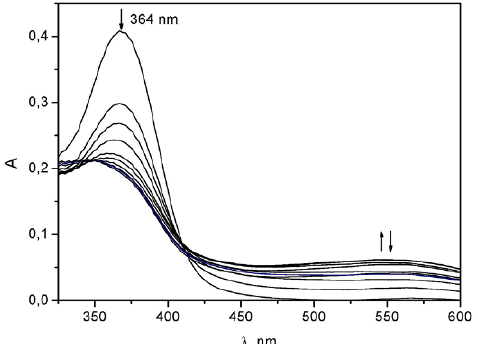
Figure 4. Time-resolved spectra of 15 µM quercetin taken 0, 0.2, 0.6, 1, 1.6, 2, 3, 5, 7, and 9 seconds after mixing with 100 µM peroxynitrite at pH